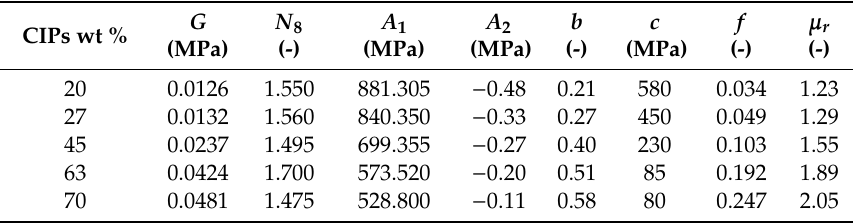
Figure 19. Collected experimental data of magnetorheological material samples subjected to loading and unloading cycles under the action of a magnetic flux density value of 52.2 mT. Notice that for increasing wt % of CIPs, the material shear moduli, the engineering stress, the dissipation of energy, and residual strains tend to increase. Table 1. Material constants used to fit the cyclic experimental data. Applied magnetic flux density of B = 52.2 mT, with a magnetic permeability of µ = µ r µ 0 , and vacuum magnetic permeability equals to µ 0 = 4 π 10 ( − 7 ) H/m. Notice that there is a linear relationship between the wt % of CIPs versus the magnetic permeability